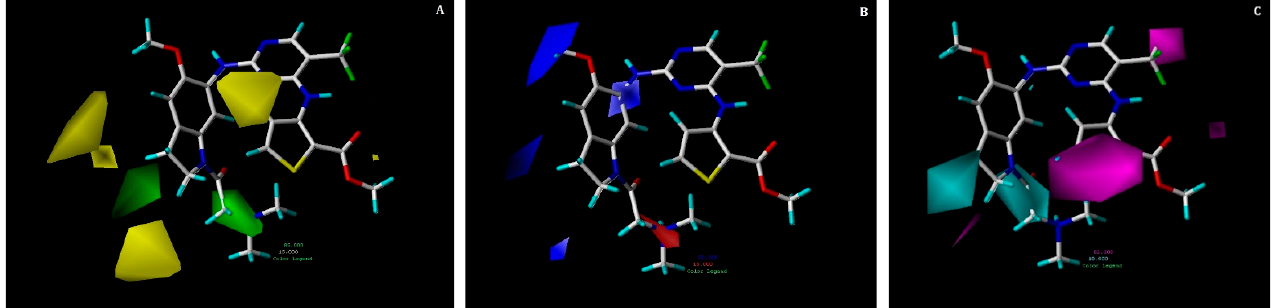
Figure 7. Contour maps for the selected CoMSIA model. ( A ) Steric contour map; ( B ) electrostatic contour map; ( C ) hydrophobic contour map. Green contours show regions that are favorable for bulky substitutions, whereas yellow contours show unfavorable regions; blue contours favor electropositive, while red does not. Magenta contours show the regions favorable for hydrophobic substitutions, whereas cyan contours show unfavorable regions.